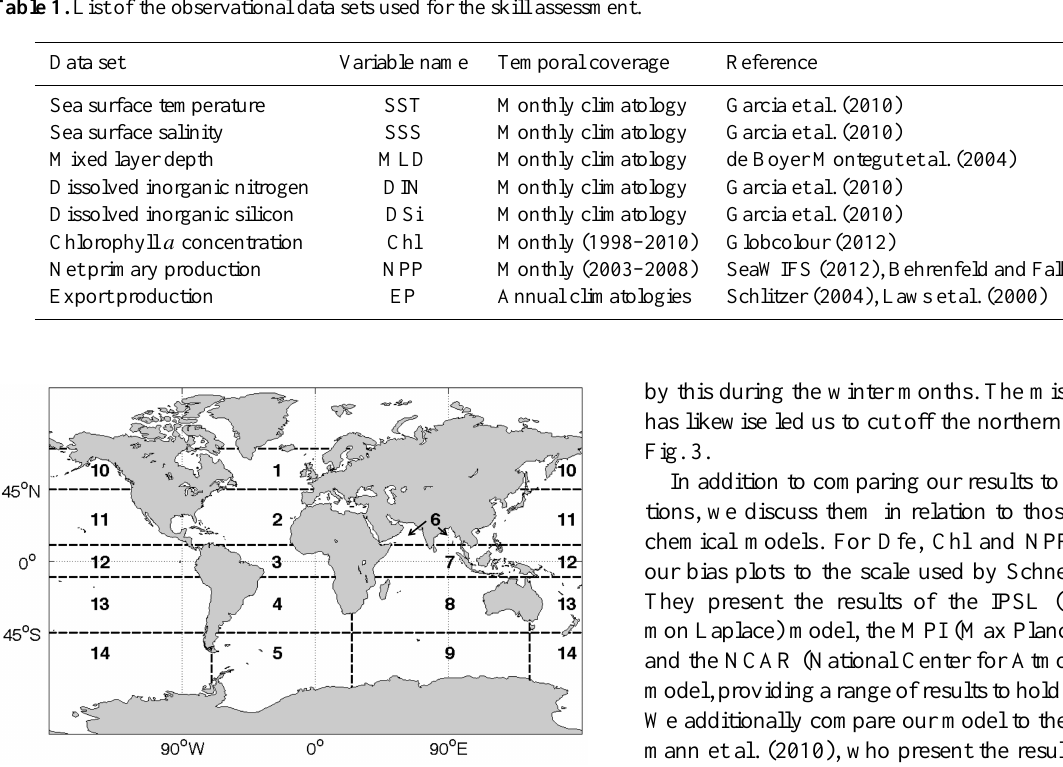
Table 1. List of the observational data sets used for the skill assessment.